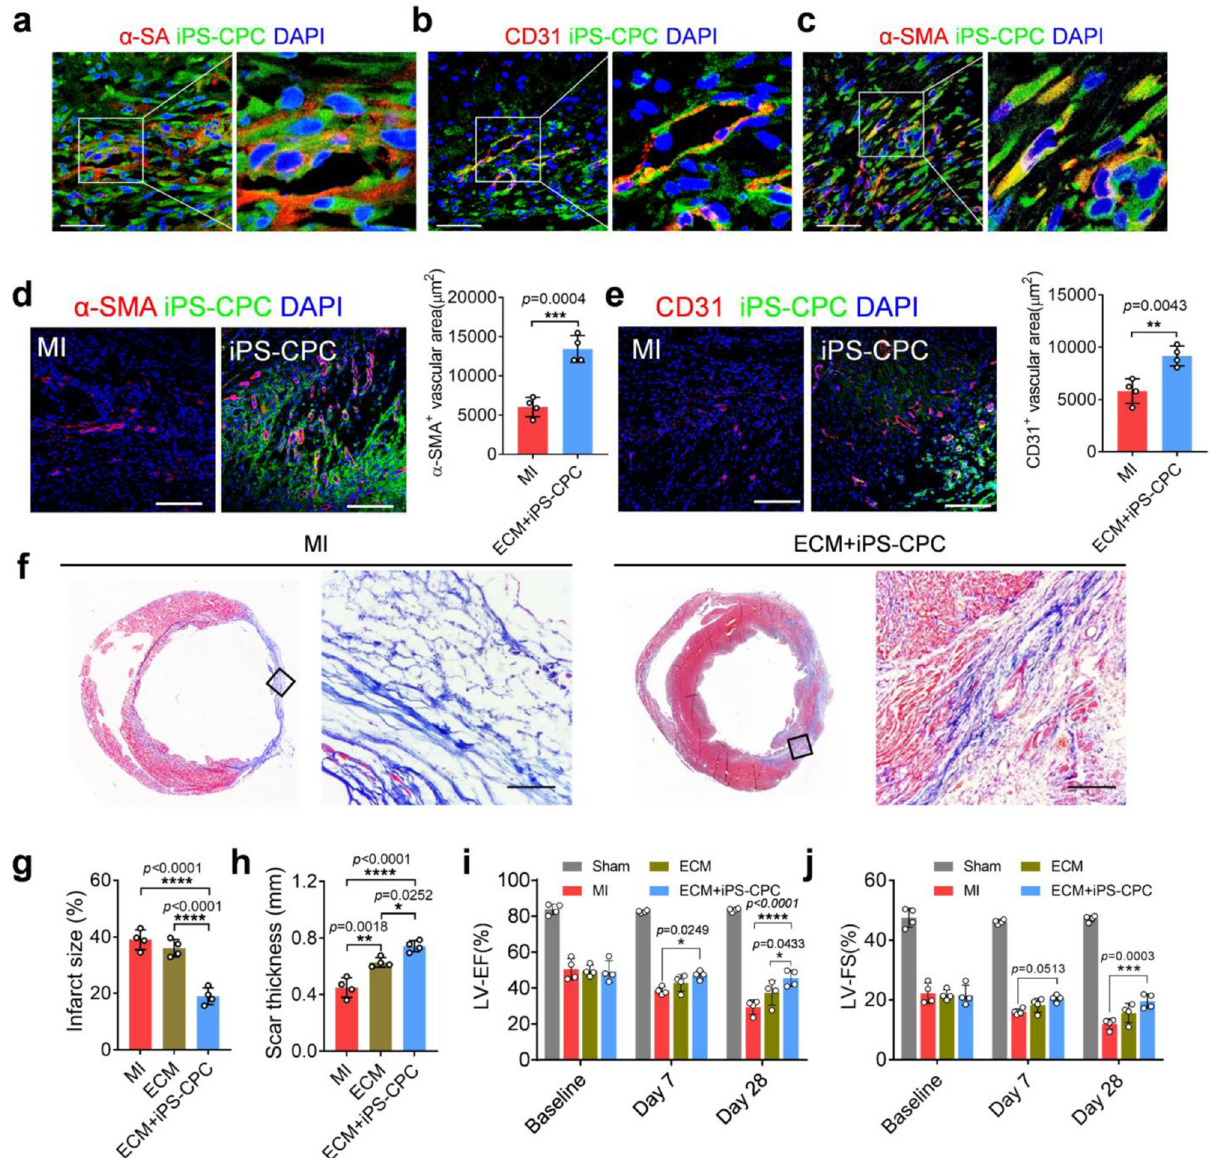
Fig. 2 iPC-injected iPS-CPCs contribute to cardiac regeneration and repair in a rat model of MI. a – c Hearts were collected 7 days after injection, and in vivo differentiation of iPS-CPCs into cardiac and vascular lineages after iPC injection were detected. Scale bar, 60 μ m. d , e Representative confocal microscopic images showing immunostaining of α -SMA and CD31 in the hearts 7 days after injection and corresponding quanti fi cation. Scale bar, 60 μ m. Data were shown as mean ± SD, n = 4 animals per group. Comparison of two groups was performed with the unpaired, two-tailed Student ’ s t -test, ** p < 0.01, *** p < 0.001. f Representative heart sections with Masson ’ s trichrome staining (red = healthy tissue; blue = scar) 4 weeks after treatment. Scale bar, 60 μ m. From the Masson ’ s trichrome-stained images, infarct size ( g ) and LV wall thickness ( h ) were quanti fi ed. Data were shown as mean ± SD, n = 4 animals per group. Comparison of three groups was performed with the two-tailed one-way ANOVA, * p < 0.05, ** p < 0.01, **** p < 0.0001. i , j iPC injection of iPS-CPCs in ECM improved cardiac functions. Data were shown as mean ± SD, n = 4 animals per group. Statistical analysis was performed with two- tailed two-way ANOVA, * p < 0.05, *** p < 0.001, **** p < 0.0001. i p = 0.0249 (ECM + iPS-CPC vs MI, day 7), p < 0.0001 (ECM + iPS-CPC vs MI, day 28), p = 0.0508 (ECM vs MI, day 28), p = 0.0433 (ECM + iPS-CPC vs ECM, day 28). j p = 0.0513 (ECM + iPS-CPC vs MI, day 7), p = 0.0003 (ECM +